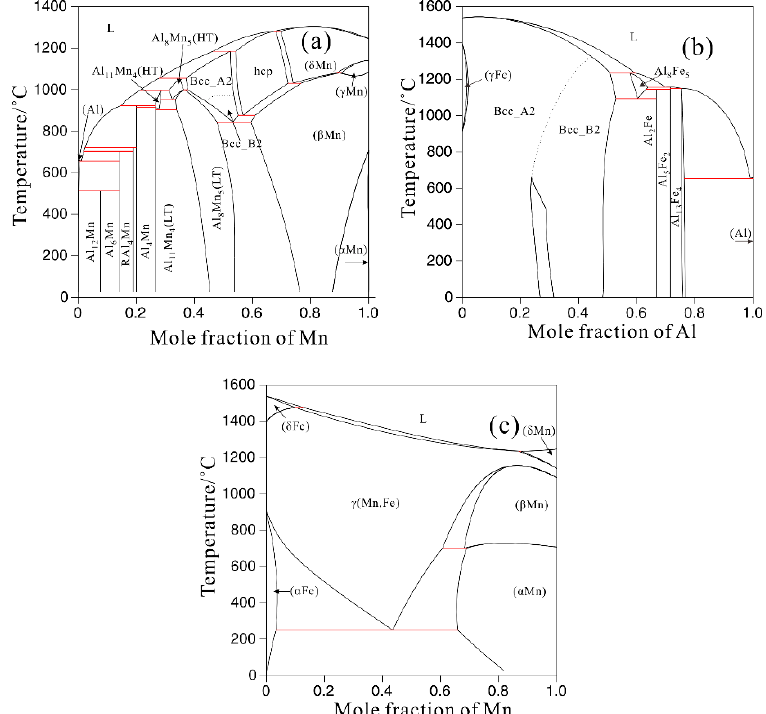
Figure 2. Calculated phase diagrams of binary systems based on the self-constructed Mg-Al-Mn-Fe database: ( a ) Al-Mn, ( b ) Al-Fe, ( c ) Fe-Mn. The dashed line in ( b ) represents the calculated Bcc_A2/Bcc_B2 transition line.